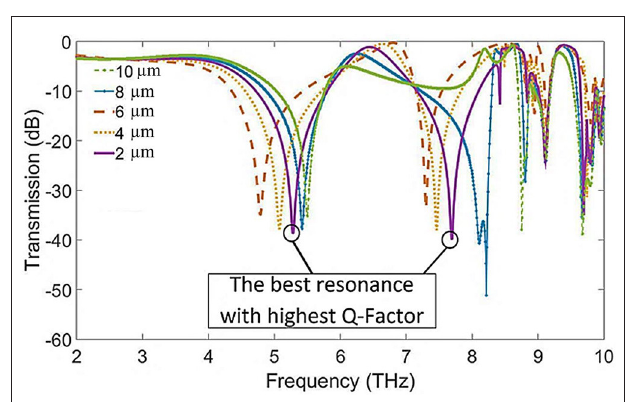
FIGURE 3 | Different resonances calculated by variation in the thickness of the metal structure. The plotted curves reveal the best value of the metal thickness for the highest Q-factor.